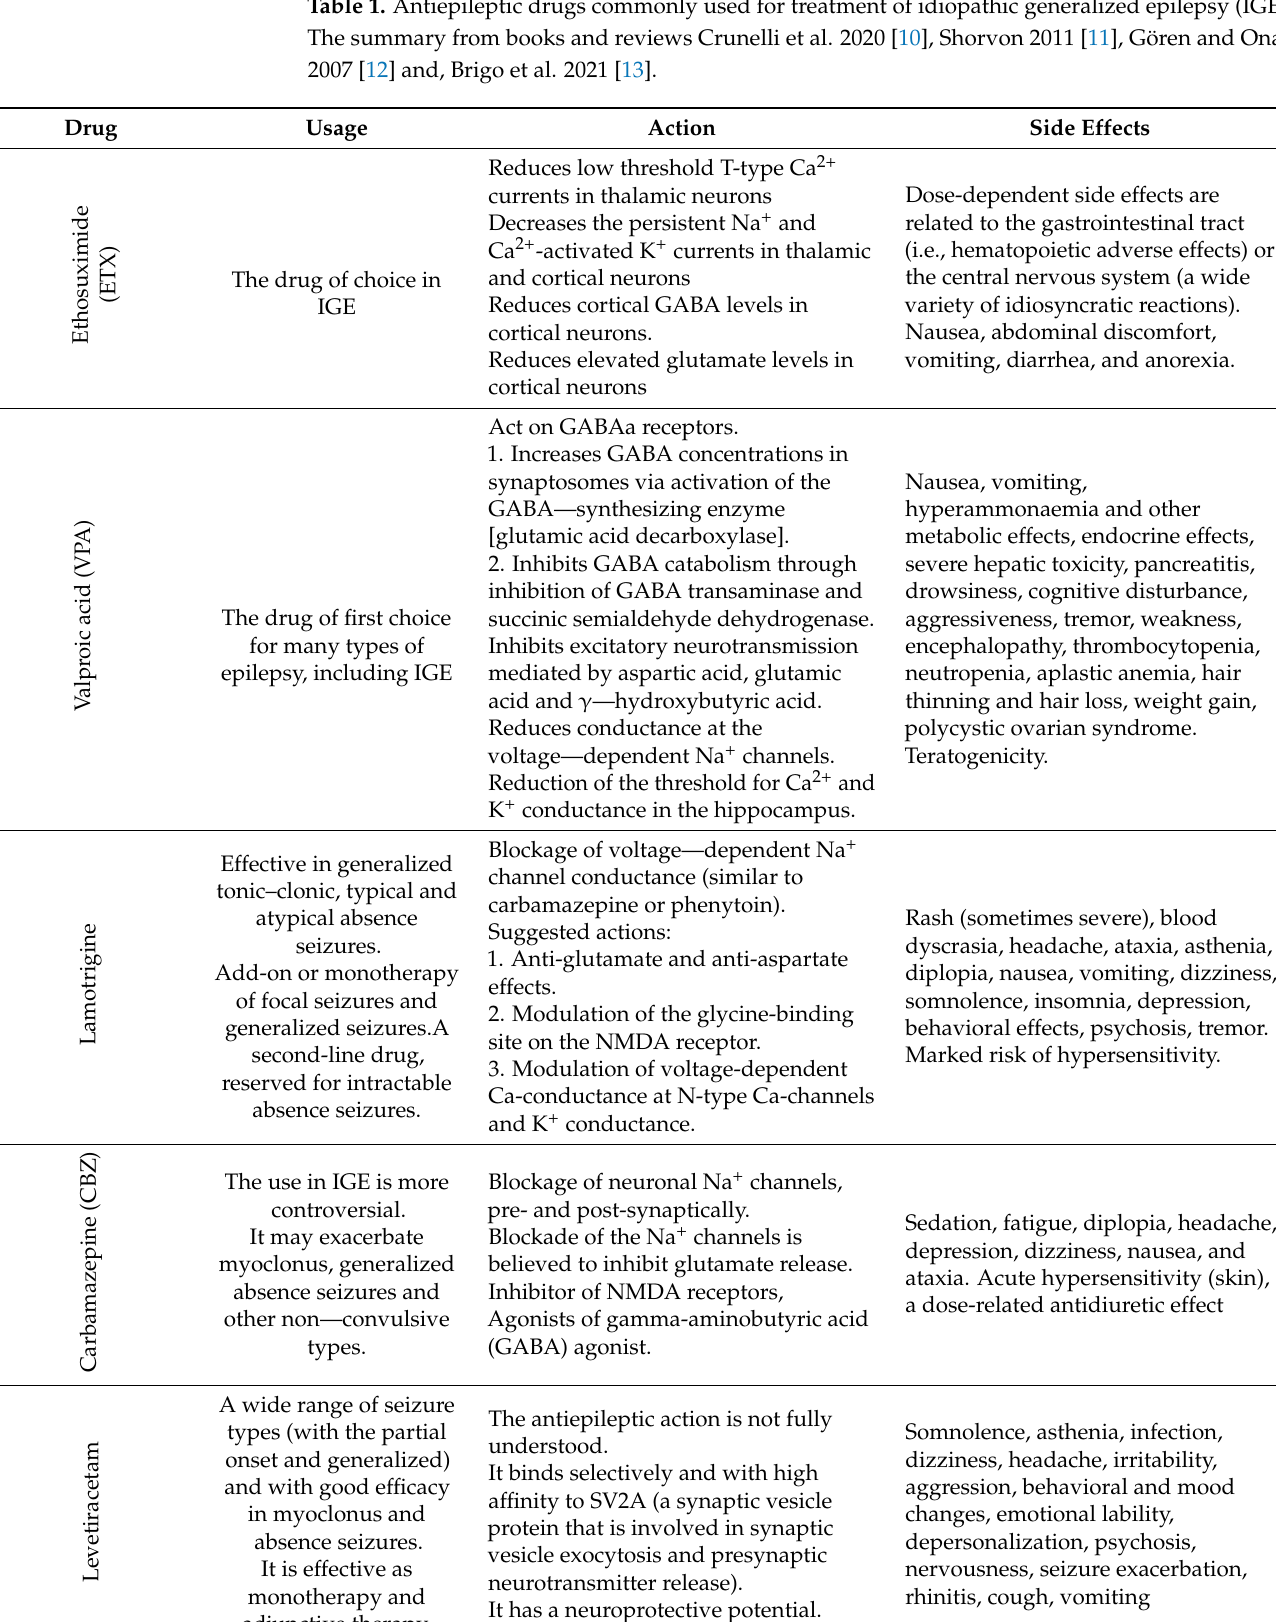
Table 1. Antiepileptic drugs commonly used for treatment of idiopathic generalized epilepsy (IGE). The summary from books and reviews Crunelli et al. 2020 [10], Shorvon 2011 [11], Gören and Onat 2007 [12] and, Brigo et al. 2021